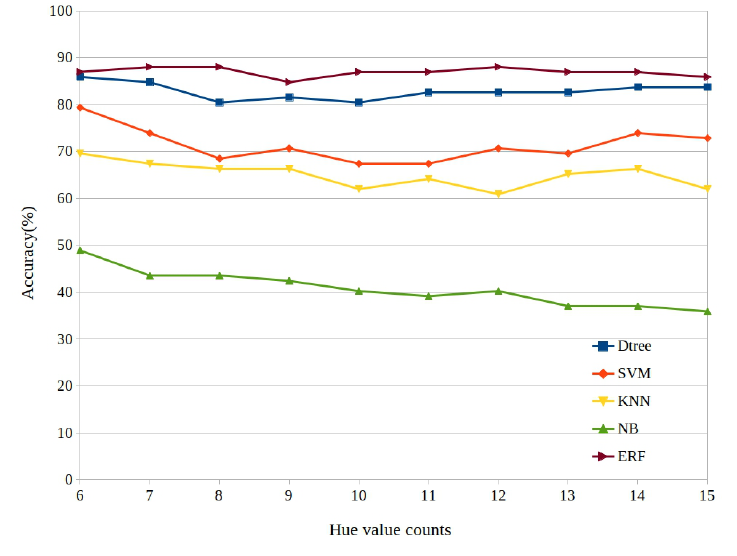
Figure 12. Accuracy with